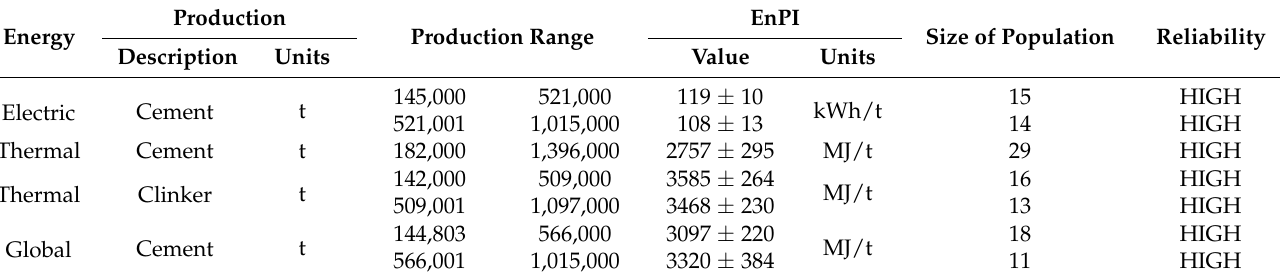
Table 1. NACE 23.51: real electric, thermal, and global EnPIs.